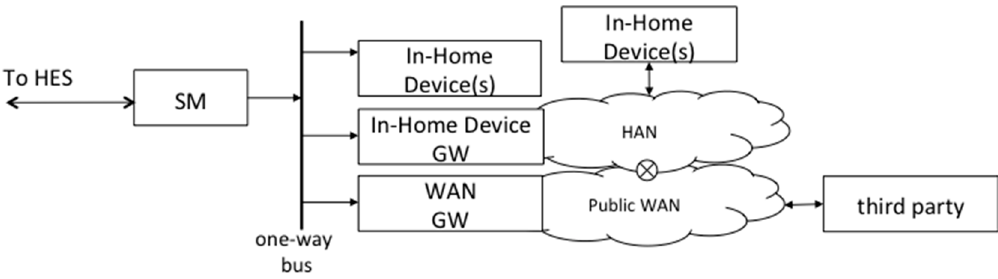
Figure 6. Architecture 4: two-tier model.